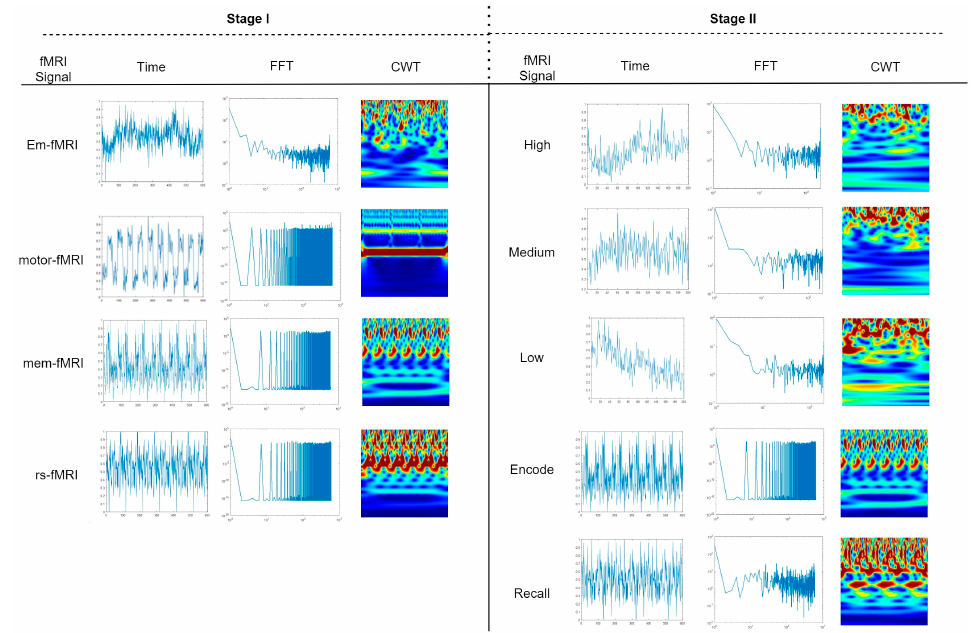
Figure 3. BOLD signal of a selected voxel generated during fMRI acquisition and its FFT (logarith- mic scale) sequences and CWT images. Stage I and Stage II represent the stages in which the signals are used in our classi fi cation systems.